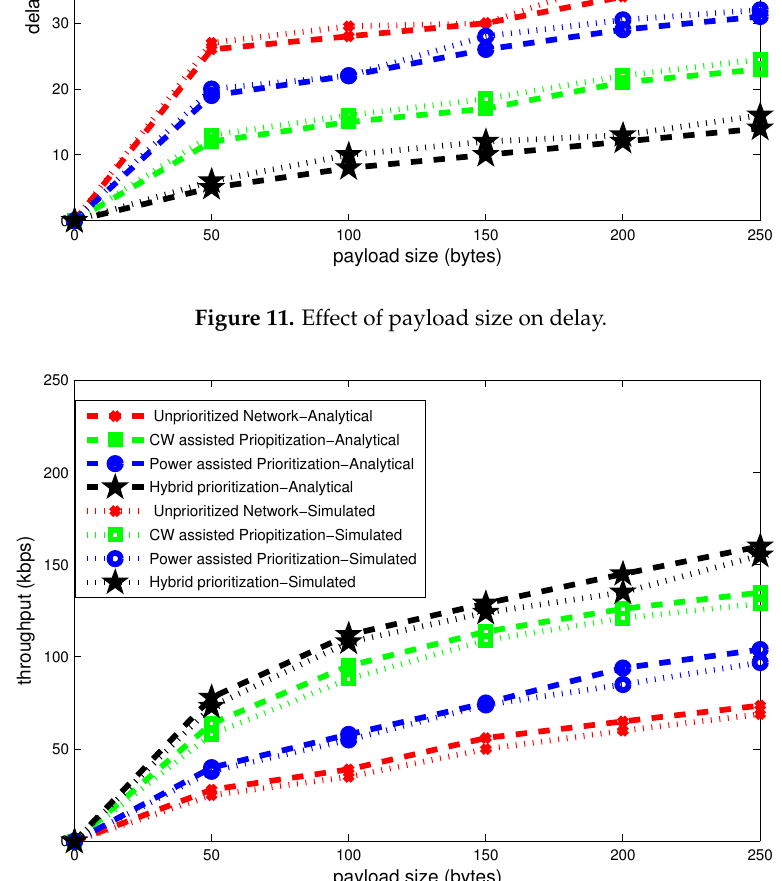
Figure 12. Effect of payload size on